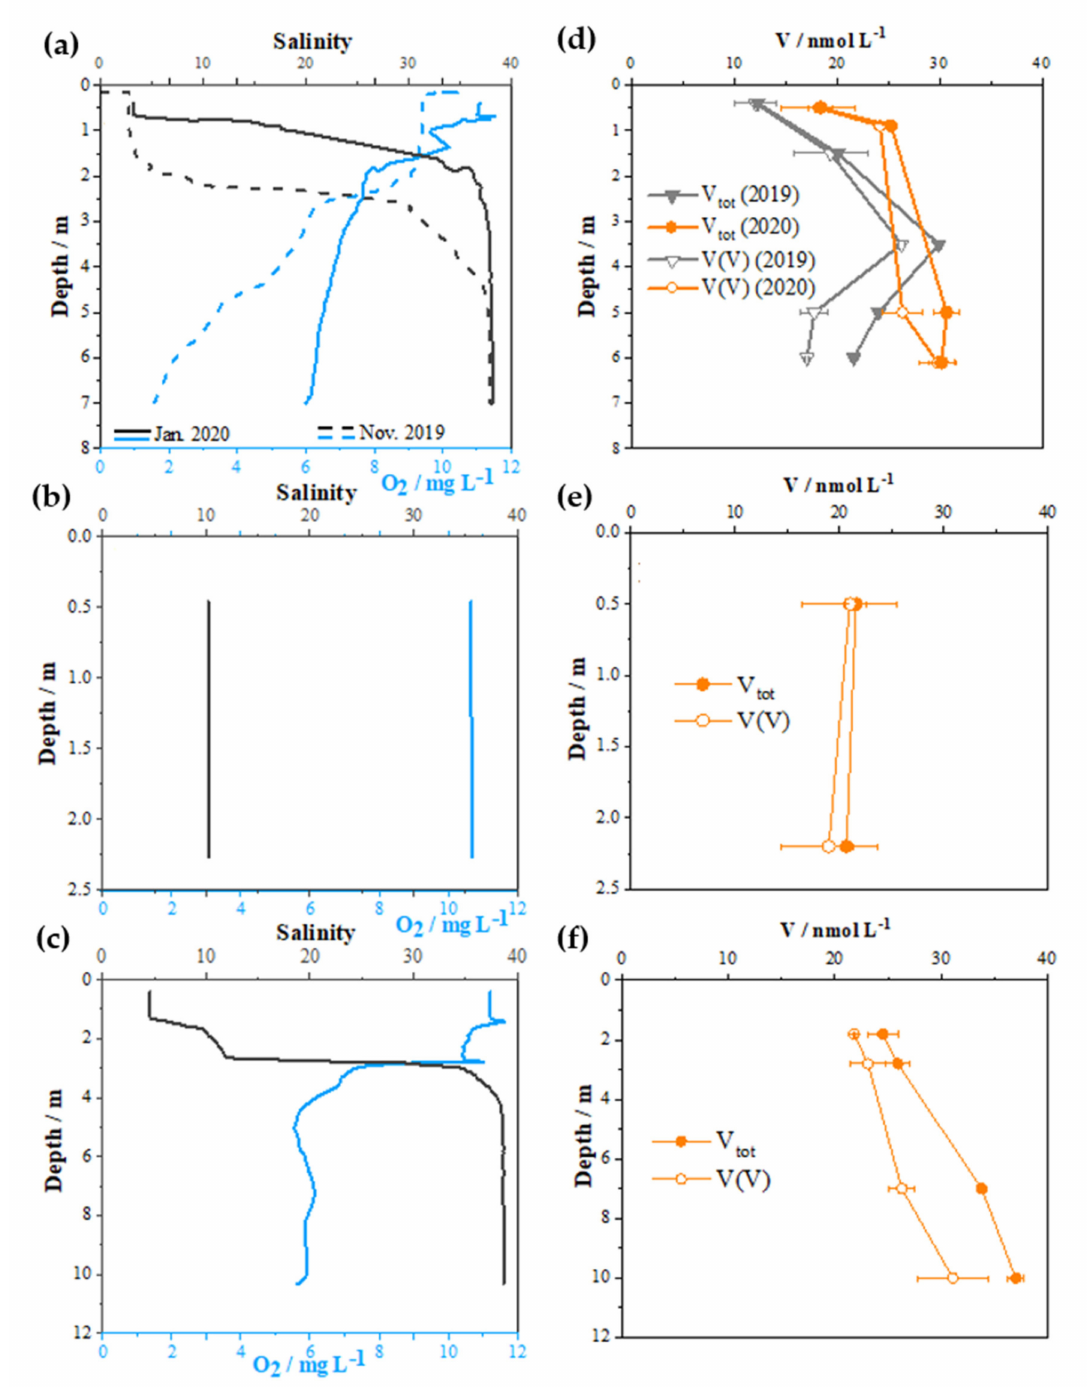
Figure 5. Vertical profiles of salinity and dissolved oxygen, and total dissolved V (full circles) and dissolved V(V) (empty circles) for SB ( a and d ), MA ( b and e ) and VP ( c and f ) sites. Dashed lines on panel ( a ) as well as grey symbols on panel ( d) represent November 2019 sampling at the SB station, while the rest of the data represent January